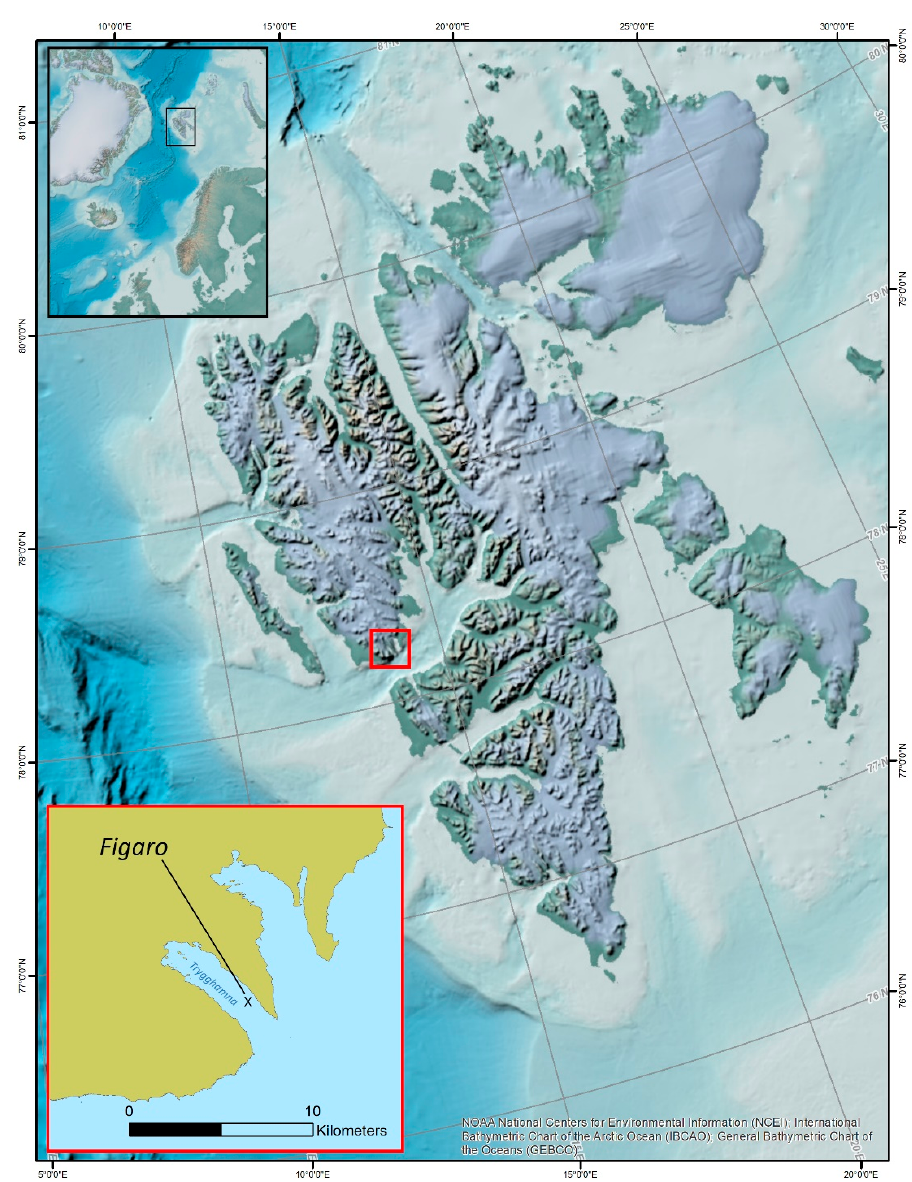
Figure 1. Trygghamna, Svalbard, with the position of the Figaro shipwreck. The figure was generated in ArcMap (v. 10.6; Esri Inc., Redlands, USA; http://desktop.arcgis.com/en/arcmap/).